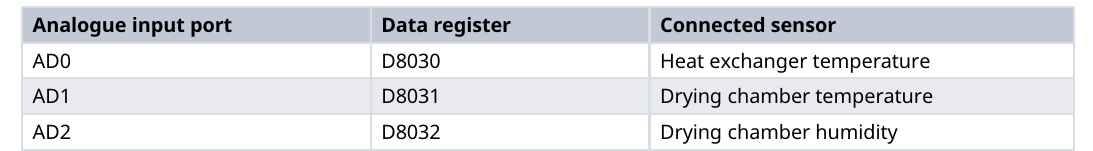
Table 5. PLC analogue input